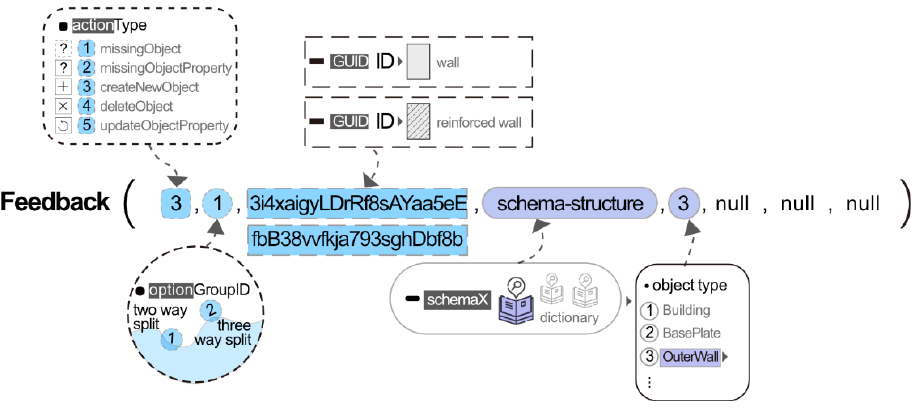
Figure 14. Feedback function for structural rework (redrawn from [48]).